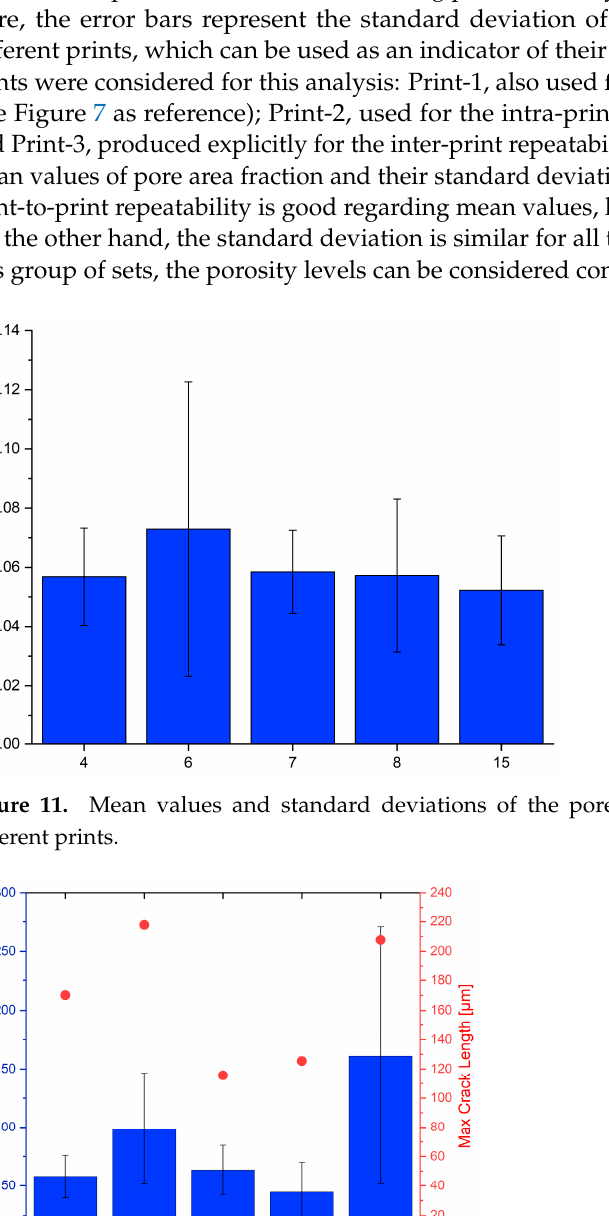
Figure 10. Results of the intra-print repetition assessment: ( a ) pore fraction and ( b ) crack density. The error bars represent the standard deviation of the three mean values calculated for each set in the same print.